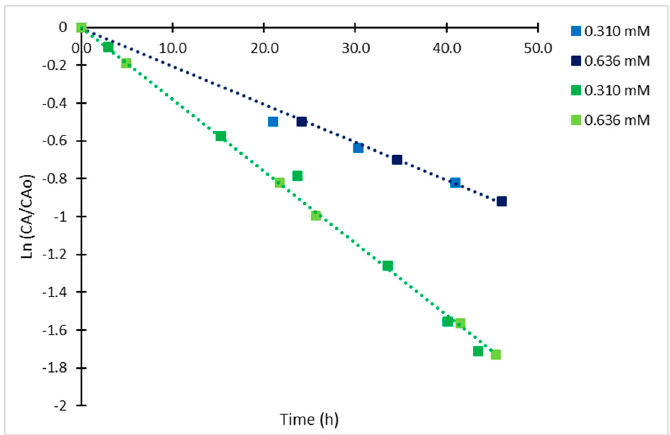
Figure 8. Semi-log plot of relative concentrations of derivatized CA at 4 °C (blue) and 25 °C (green).